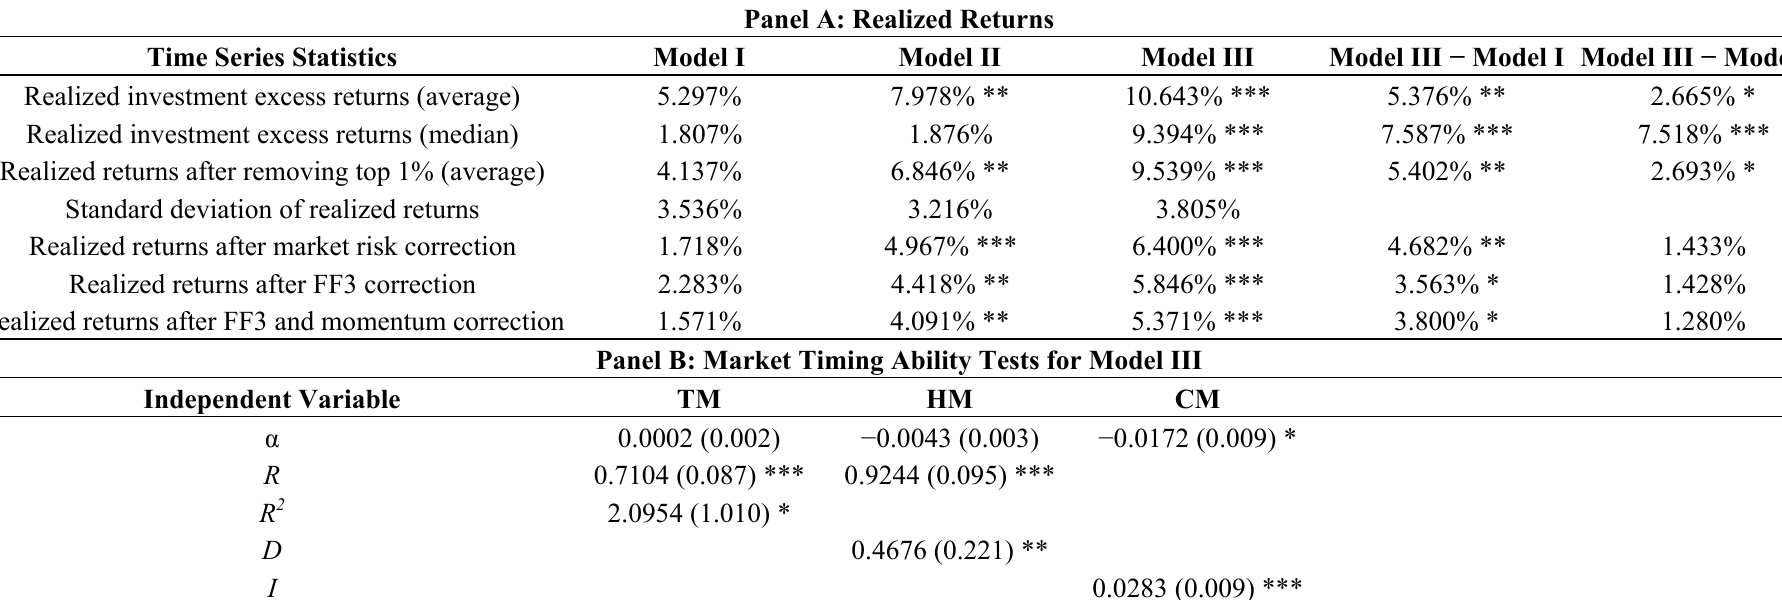
Table 4. Forecasting